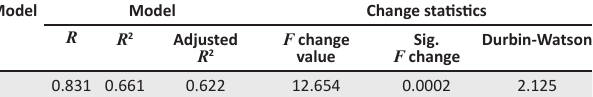
TABLE 3: Summary of the model.